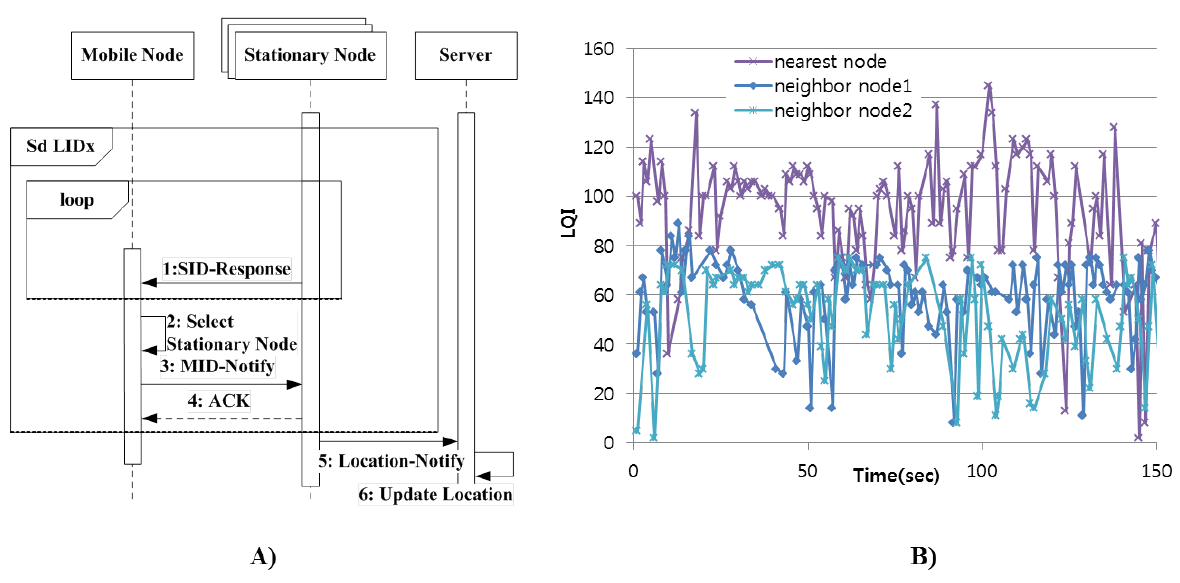
Figure 3. ( A ) Sequence diagram of LIDx protocol and location-updating sequence of mobile node. ( B ) LQI graph between mobile and stationary